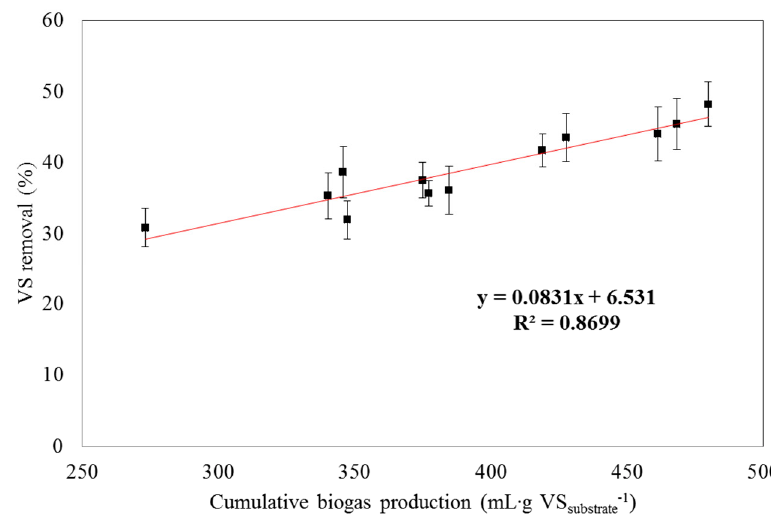
Figure 5. Correlation of biogas produced per g VS and percentage of VS removal for all the experiments.